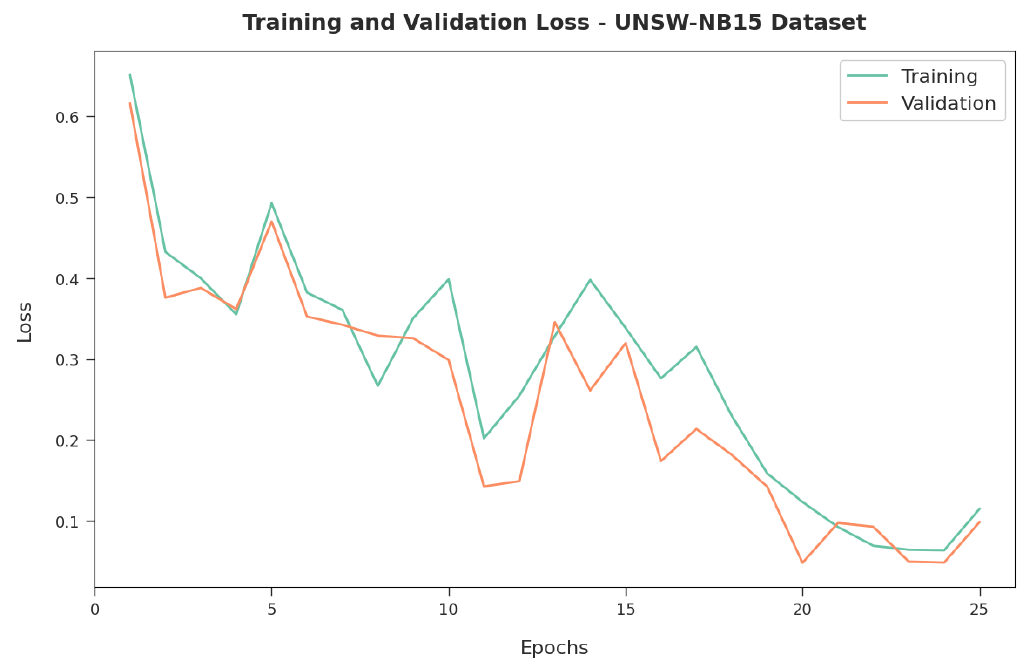
Figure 8. TL and VL analysis of OMLIDS-PBIoT technique under UNSW-NB15 dataset.